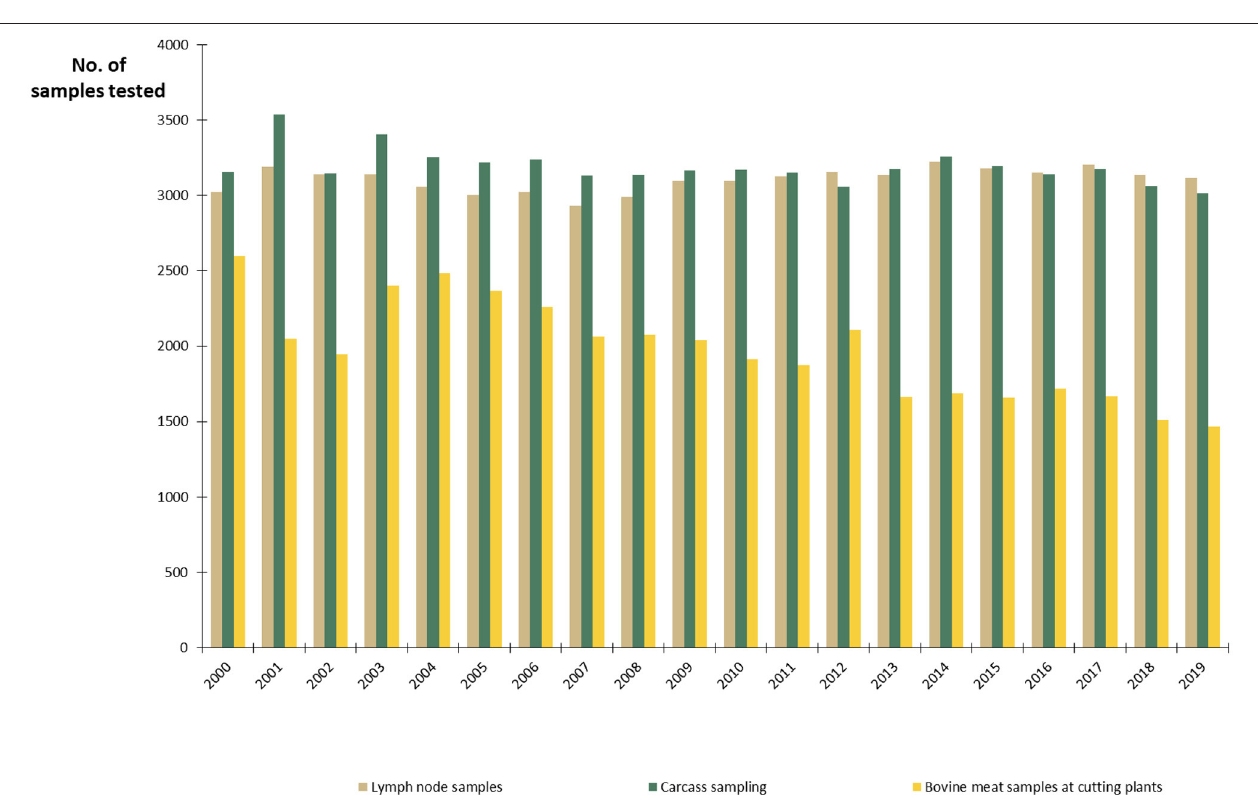
the restriction of animal movements other than to